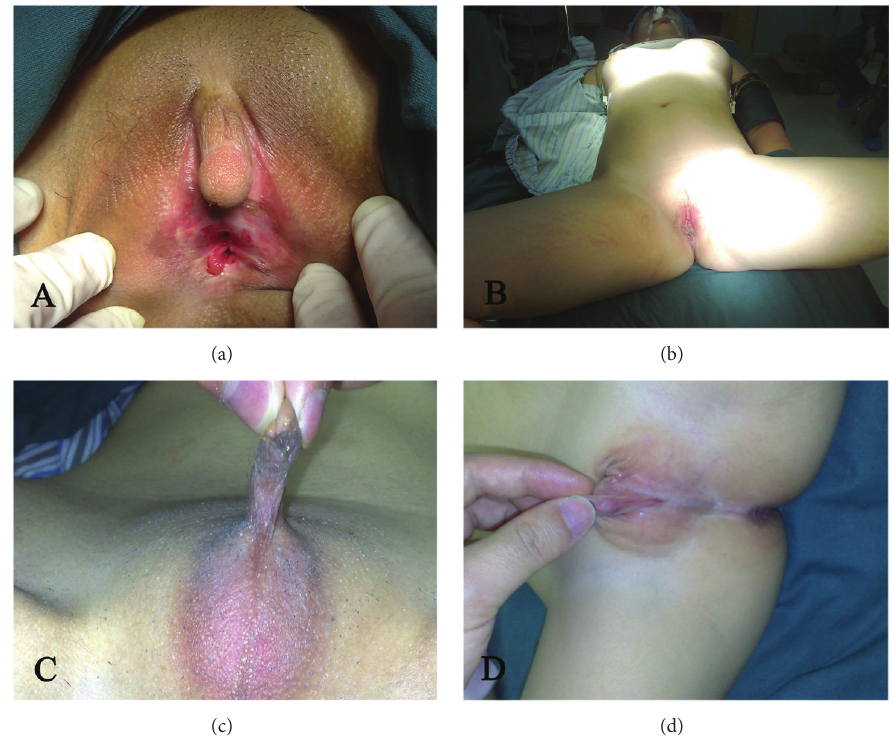
Figure 2: DSD patients. (a) 46, XX DSD. The clitoris was hypertrophic and penis-like, the gonad was ovoid, and the patient had na¨ıve uterus; (b) 46, XY DSD. Complete female externalia was observed in appearance, the vagina and breast were well developed, and bilateral testicles were found in the abdomen. (c) Ovotesticular DSD. The penis was poorly developed, and unilateral testicle and contralateral ovary were found; (d) 46, XY. Complete gonadal dysgenesis was observed. The vagina and urethra shared an outlet and the gonads were poorly developed. Patients agreed with publication of these